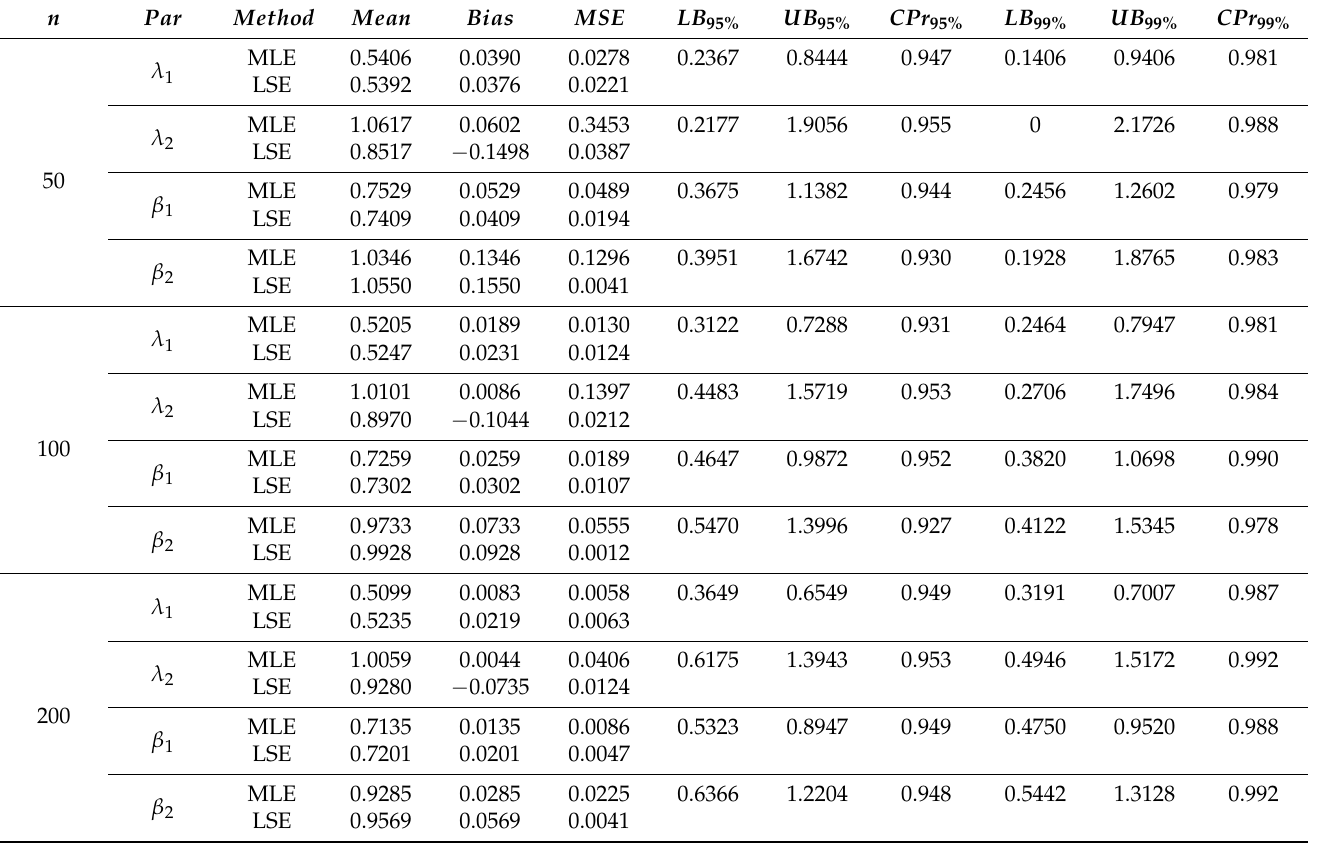
Table 2. The results of MLEs, LSEs, interval estimates, and CPrs when β 1 = 0.7, β 2 = 0.9, λ 1 = 0.5016,